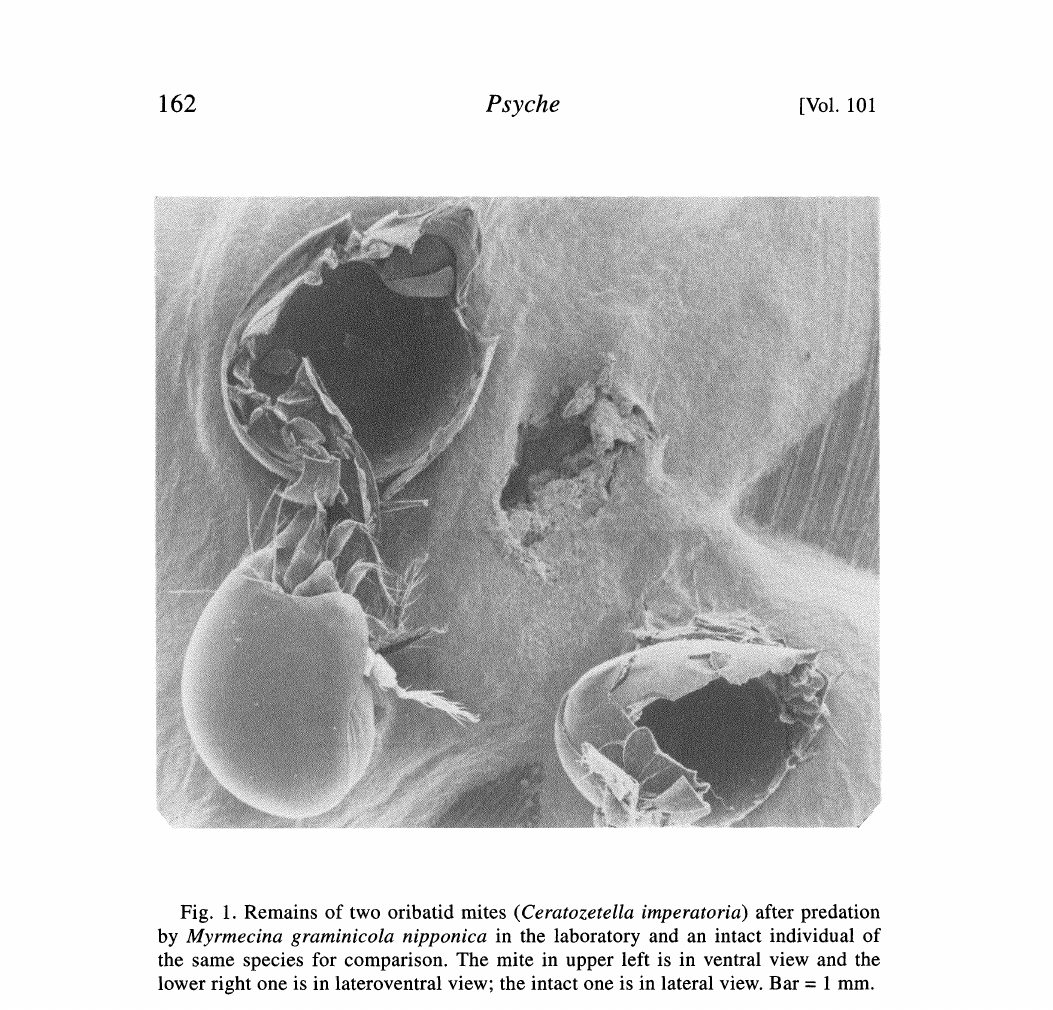
Fig. 1. Remains of two oribatid mites (Ceratozetella imperatoria) after predation by Myrrnecina graminicola nipponica in the laboratory and an intact individual of the same species for comparison. The mite in upper left is in ventral view and the lower right one is in lateroventral view; the intact one is in lateral view. Bar